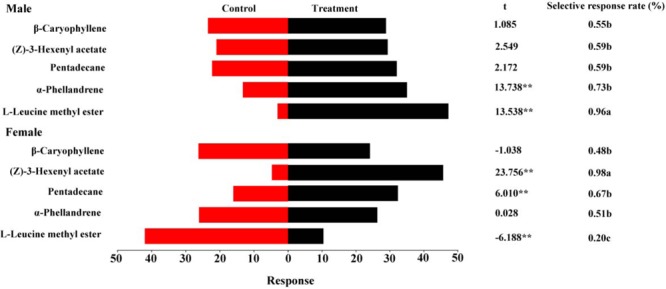
Behavioral responses of male and female DBCs to five putative HparOBP ligands at 1 μg/μl in a Y-tube olfactometer trial. A high response rate (greater than 80%) was observed for all DBC individuals. The indices were calculated using the following formulas: response = T/SUM or C/SUM, response rate = (T+C)/SUM and selective response rate = T/(T+C), where T represents the number of beetles in the treatment tube; C indicates the number of beetles in the control tube; and SUM is the number of beetles tested. Mean ± SE (N= 6). Asterisks indicate statistically significant differences between females and males (by Student’s t-test): ∗P < 0.05, ∗∗P < 0.01.